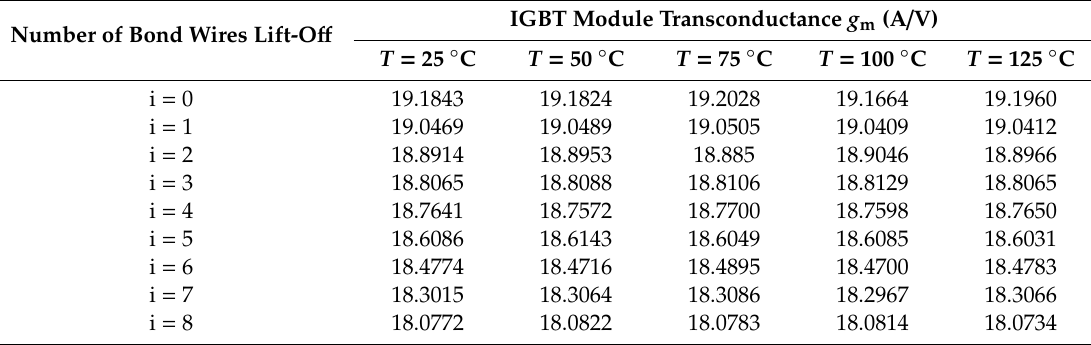
Table 7. Module transconductance of Chip 1 bond wire fault state after temperature calibration. Number of Bond Wires Lift-O